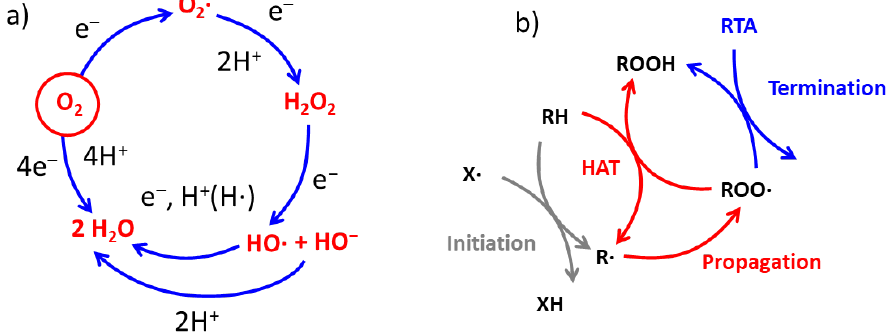
Figure 1. ( a ) Reduction processes involving the oxygen molecule, ( b ) propagation reaction leads to oxidation of organic molecules, RH, by oxygen.